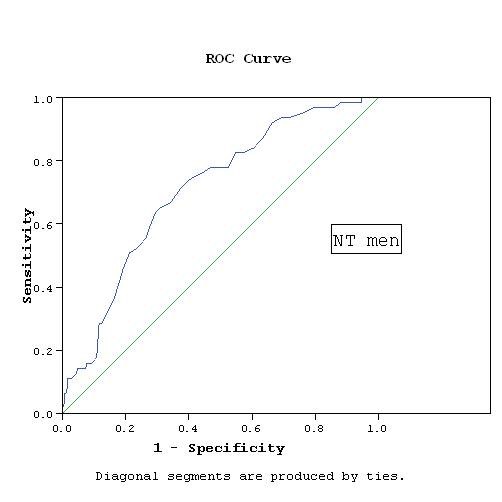
WC cutoff point by ROC curve in NT men. AUC = 0.78, p < 0.001 CI: 0.685- 0.876.